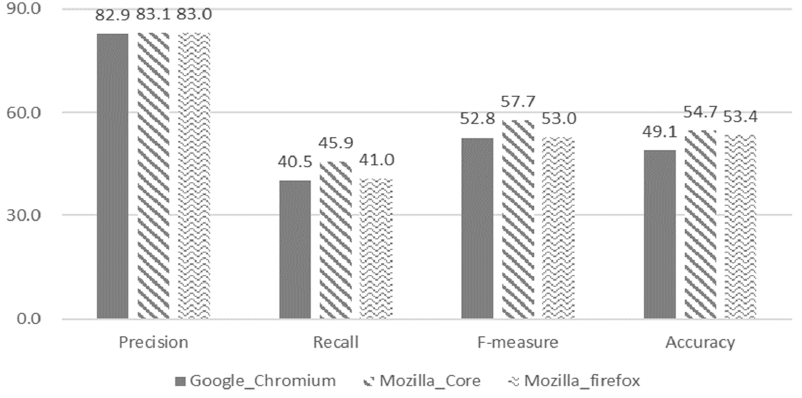
Figure 7. Performance of our approach.